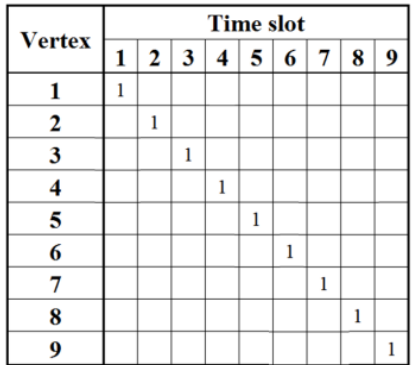
Figure 6. The initial state of the allocation matrix.